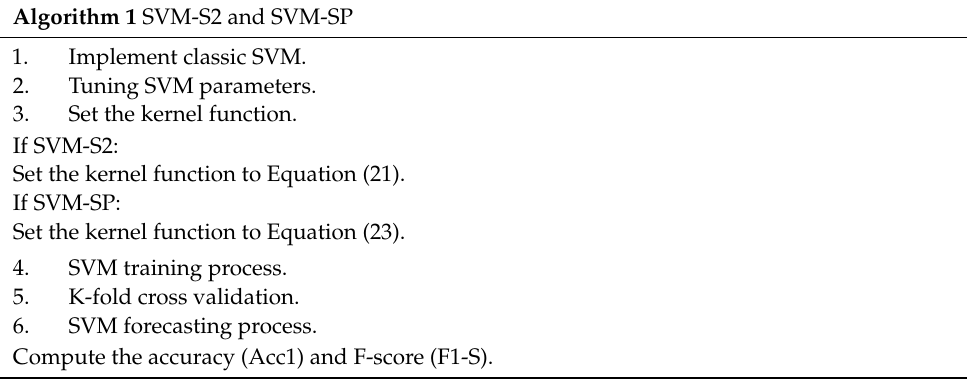
Algorithm 1 SVM-S2 and